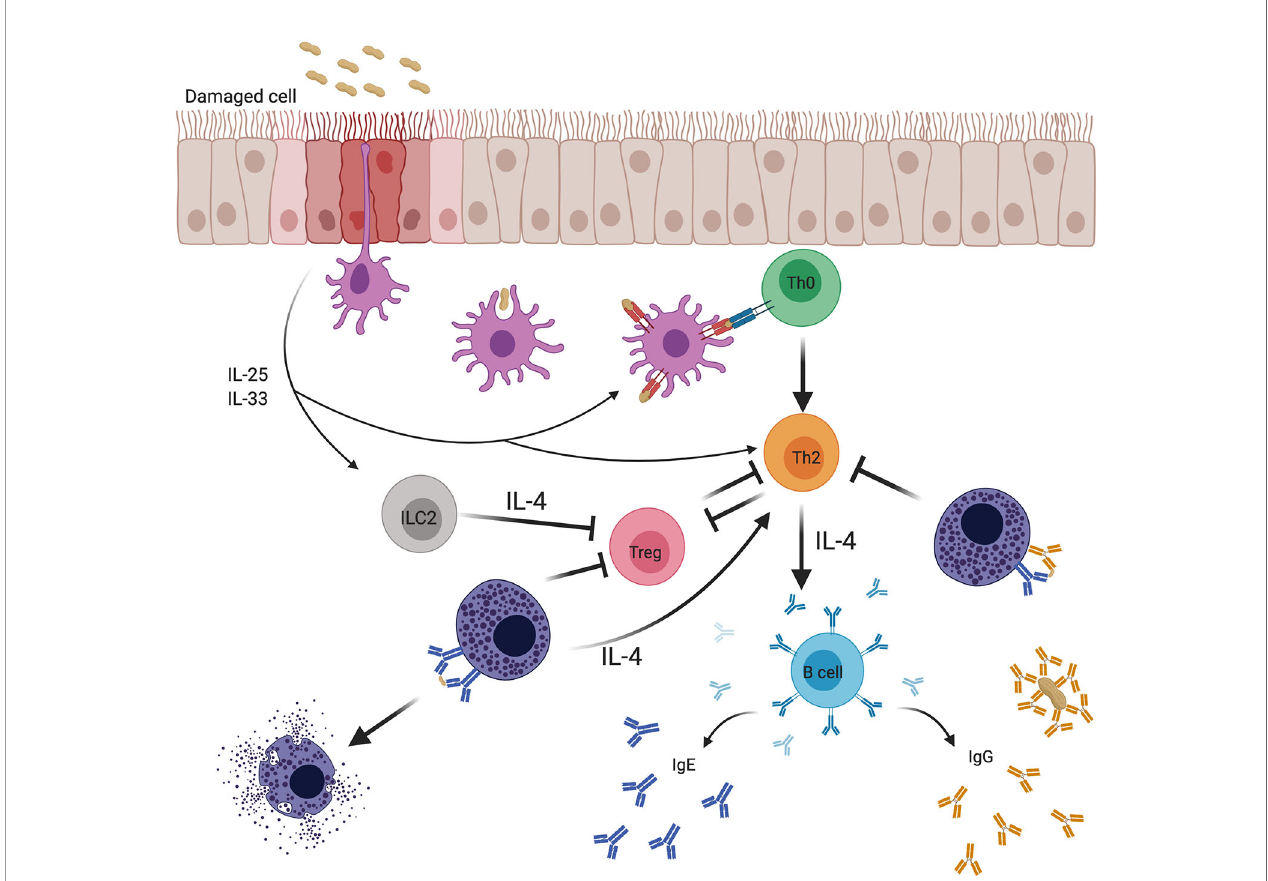
FIGURE 4 | Effects of mast cells on adaptive immune responses to food allergens and the regulation of these effects by IgE and IgG antibodies. Food antigens pass through damaged epithelium, specialized intraepithelial passages (8), or are sampled by antigen presenting cells (APCs). Epithelial cells subjected to stress or microbial signals secrete cytokines such as IL-25 and IL-33 that promote the activity of various cellular mediators involved in the breakdown of tolerance. Mucosal APCs present antigen to naïve T cells that mature into Th2 cells in the context of a Th2-conducive environment. Th2 cells are known to both depend on IL-4 for their differentiation and survival, and to produce IL-4 that drives IgE isotype switching by B cells and mast cell expansion, while inhibiting the production of regulatory T cells (Tregs) and subverting their function. Mast cells sensitized with allergen-speci fi c IgE and type 2 innate lymphoid cells (ILC2s) provide a priming source of IL-4, initiating and sustaining the Th2 environment. In contrast, allergen-speci fi c IgG antibodies induced during natural allergen resolution or during OIT can inhibit mast cell activation via signaling through Fc g RIIb receptor. Inhibition of mast cell activation by IgG can break the positive feedback loop between mast cells and